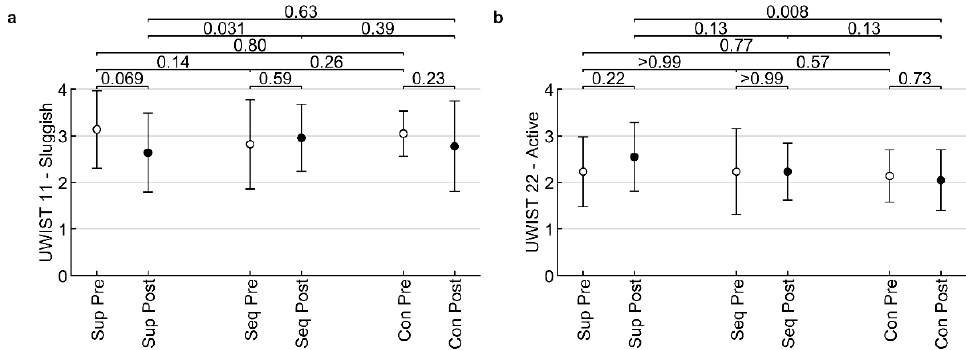
Figure 7. Influence of low-frequency sound on two items of UWIST – Sluggish ( a ) and Active ( b ) in pre/post measures. Sup—placebo supine; Seq—stimulation with amplitude modulation of LFV; Con –constant LFV. The values displayed above the clips are p -values of Fisher’s LSD tests.